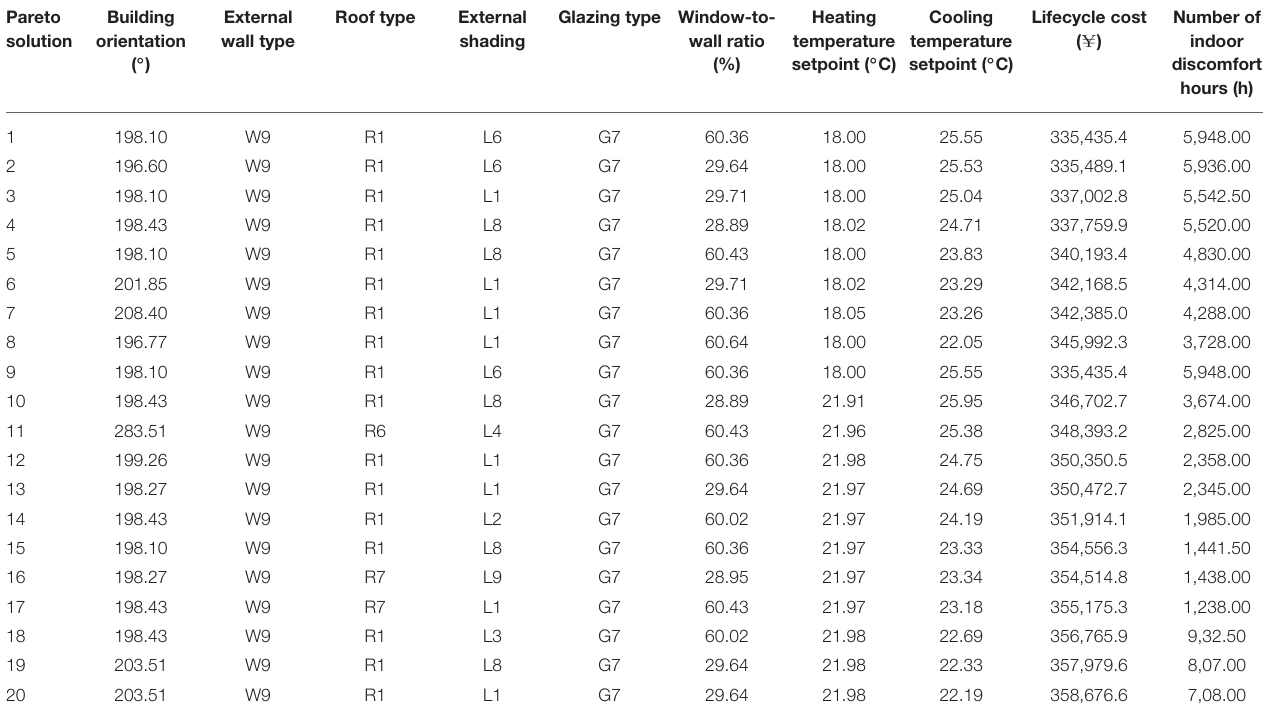
TABLE 9 | 20 sets of Pareto solutions randomly selected for Wuhan considering the trade-offs between life cycle cost and number of indoor discomfort hours. Pareto